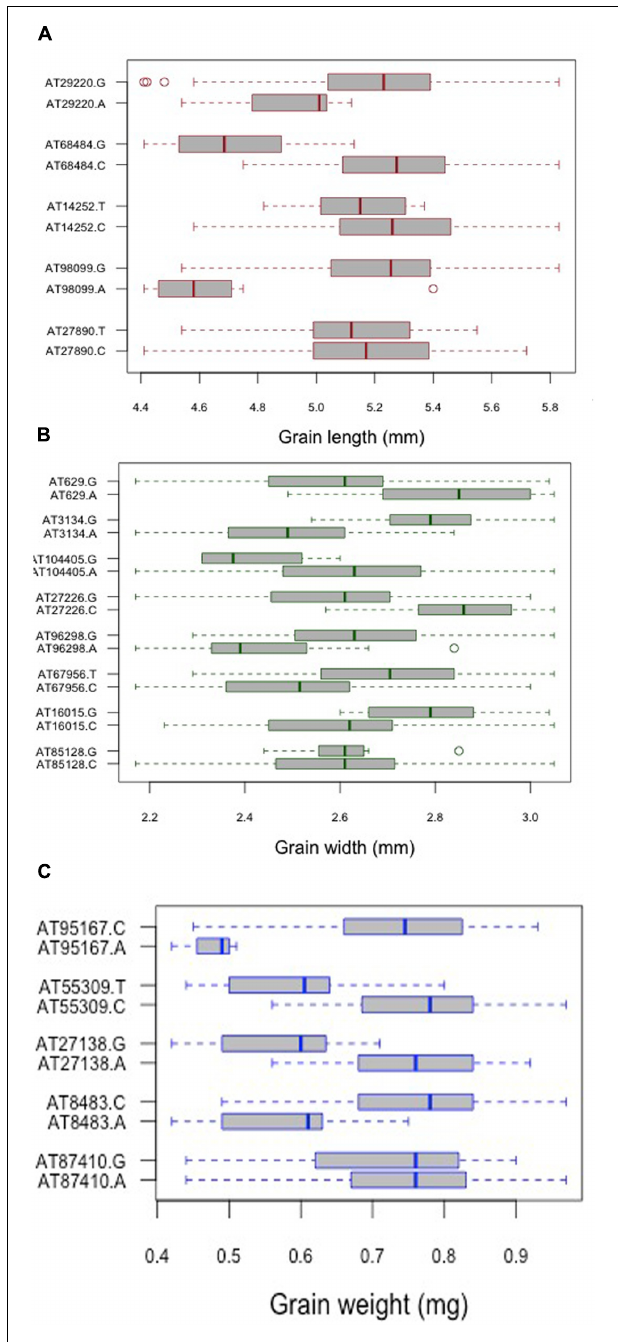
FIGURE 6 | Comparison of the allelic effects for the SNP markers associated with (A) grain length, (B) grain width, and (C) grain weight. Kruskal–Wallis test was used to determine the significant differences between the mean values of two